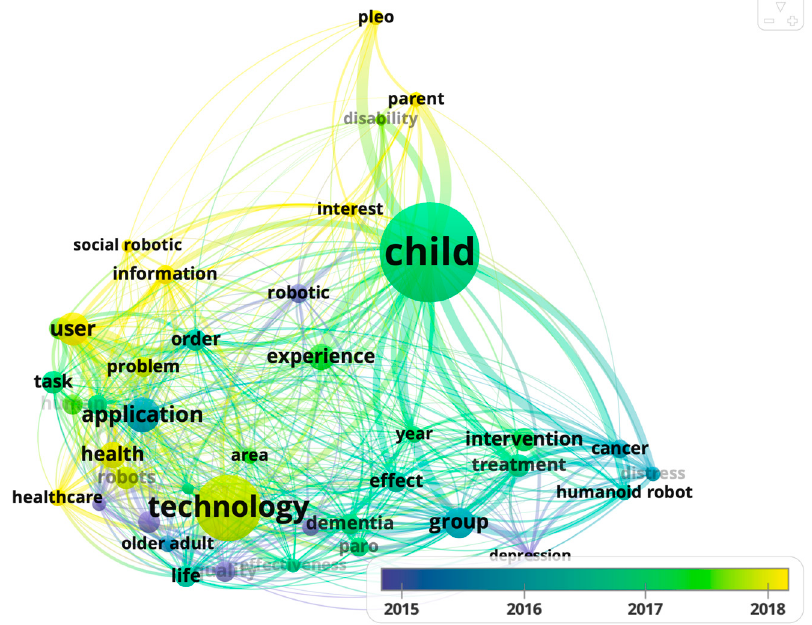
Figure 2. Evolution in time of titles and abstract terms.